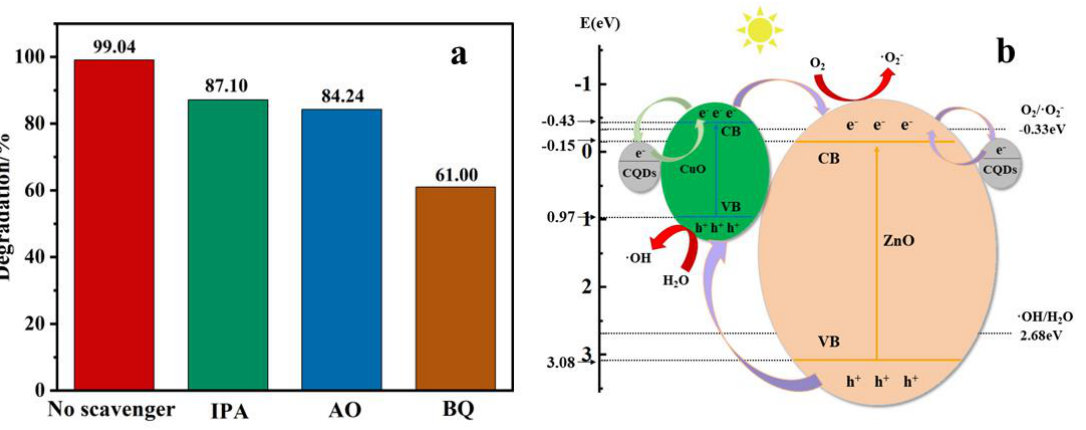
Figure 4. Free radical trapping experiment results ( a ) and photocatalytic degradation mechanism ( b ) of CZC@PAN.